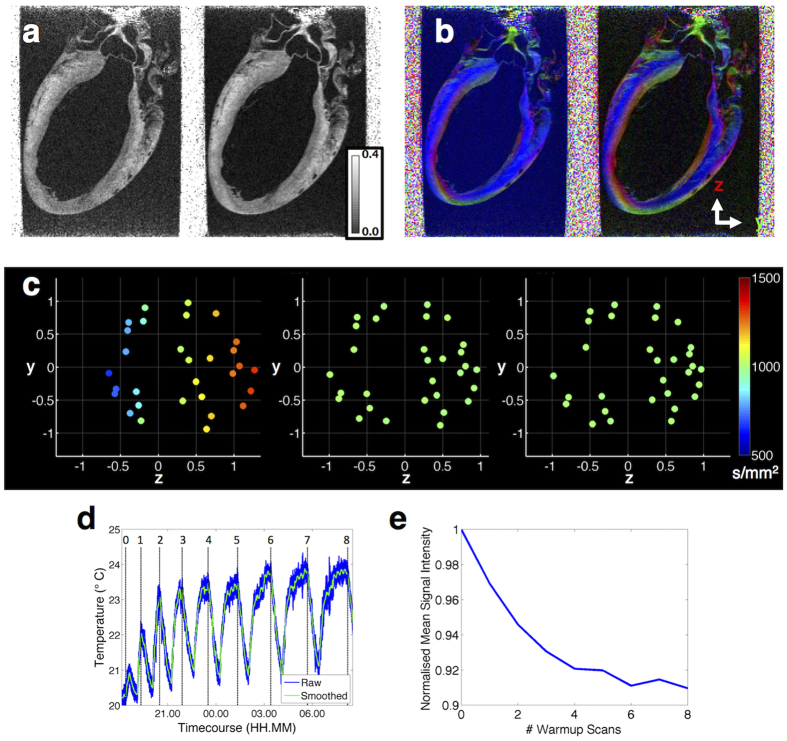
Technical refinements in DTI.(a) FA maps, in a mid-sagittal plane, show improved SNR when acquired with dynamic (right) over static (left) receiver gains. (b) v1 maps reconstructed from offset (left) and calibrated (right) data illustrate how poor gradient calibration leads to bias in v1. (c) Projection of the 3D diffusion-weighting scheme in the y-z plane without adjustment (left), with reversed diffusion gradient correction (middle) and with prospective diffusion gradient adjustment (right). Each point represents the diffusion-weighting in a single direction along the x, y and z-axes, normalised by the nominal b-value of 1,000 s/mm2. These plots are colour-coded by the effective b-value, including contributions from diffusion gradients, imaging gradients and cross-terms. The unadjusted scheme shows a bias towards higher/lower b-values along the +ve/−ve direction with respect to the refocusing crusher gradients (+z), as reflected by the colour variation across the plot. The proposed prospective diffusion gradient adjustment ameliorates this bias, as per the reversed diffusion gradient method, but without the associated doubling in acquisition time. (d) Timecourse of temperature measurements over multiple warm-up and cooldown cycles. Warm-up scans consisting of 0 to 8 DW scans preceded each b = 0 image acquisition. Start times of b = 0 acquisitions denoted by numbers 0 to 8. Scans were paused for 30 min after each b = 0 acquisition to allow samples to cool. (e) Mean signal intensity variation in the myocardium in the whole heart in non-diffusion-weighted (b = 0) datasets after 0 to 8 warm-up diffusion-weighted scans. The rising temperature led to a drop in b = 0 image intensity, reaching a steady state after about 6 warm-up scans.